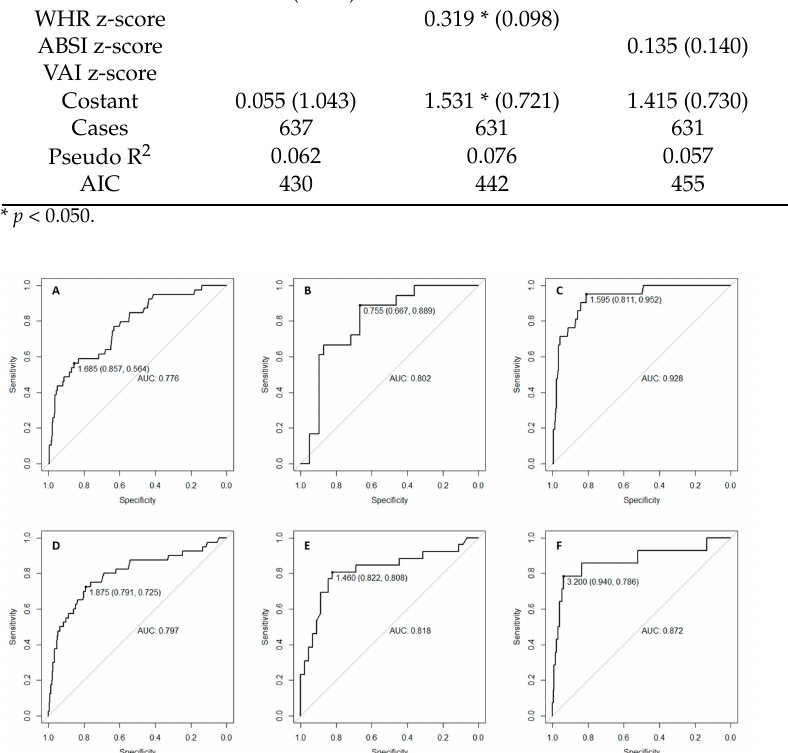
Figure 2. ROC analysis to find the optimal VAI cut-off to identify MetS in boys ( A ), boys aged <10 years ( B ), boys aged ≥ 10 years ( C ), girls ( D ), girls aged <10 years ( E ) and girls aged ≥ 10 years ( F